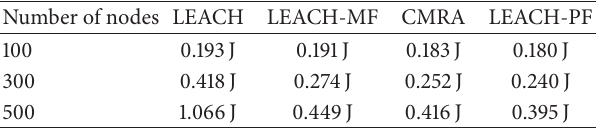
Figure 2: The diagram of establishing a routing tree.